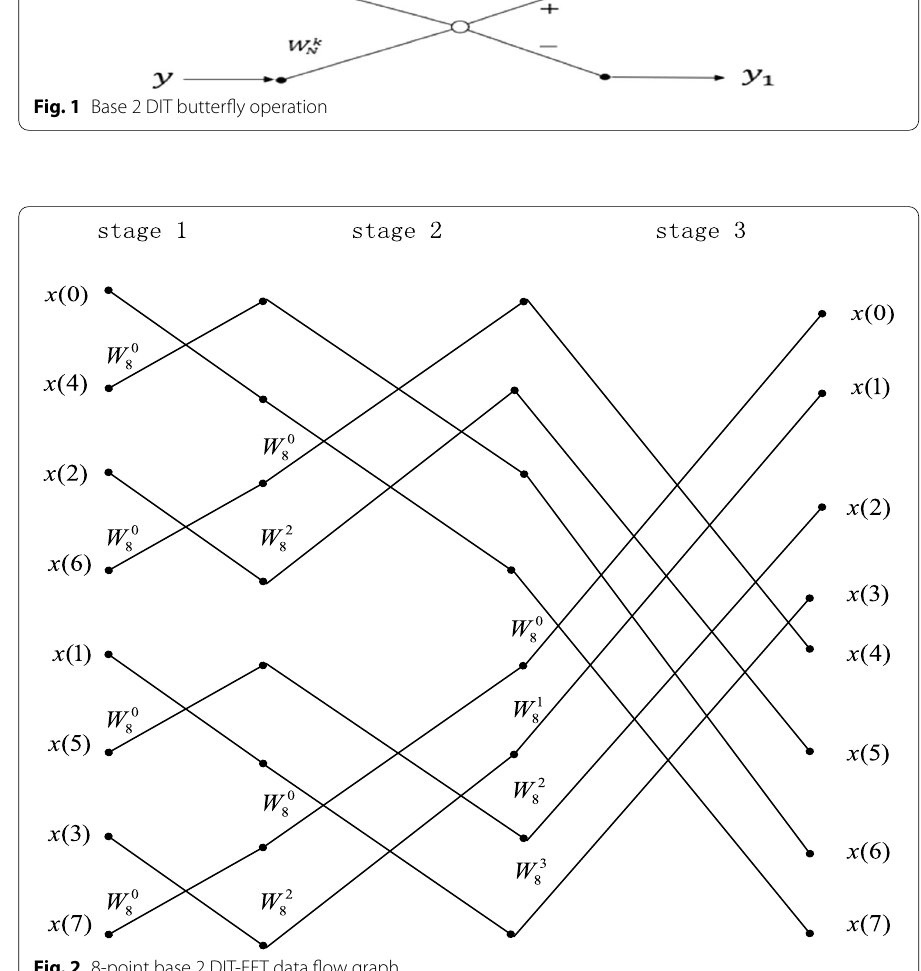
Fig. 2 8-point base 2 DIT-FFT data flow